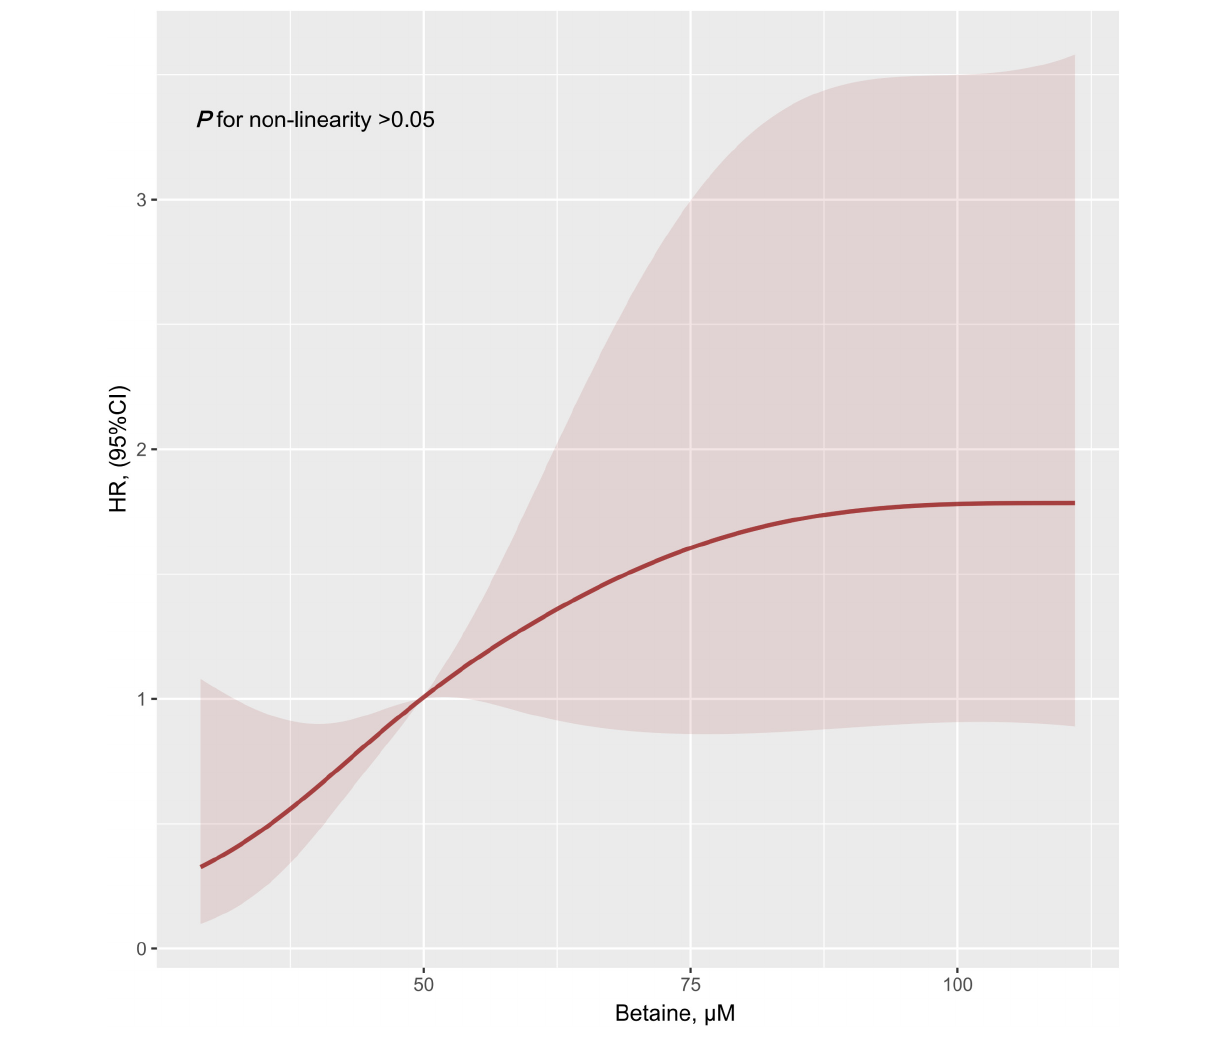
FIGURE 1 | Restricted cubic spline result of plasma betaine levels in relation to hazard ratio for the risk of clinical outcomes. Dark red line with 95% CI shaded in light red. HR, hazard ratio; CI, confidence